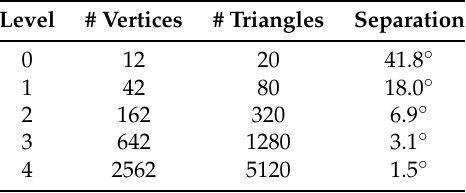
Table 1. Levels of Refinement for an Icosahedron.